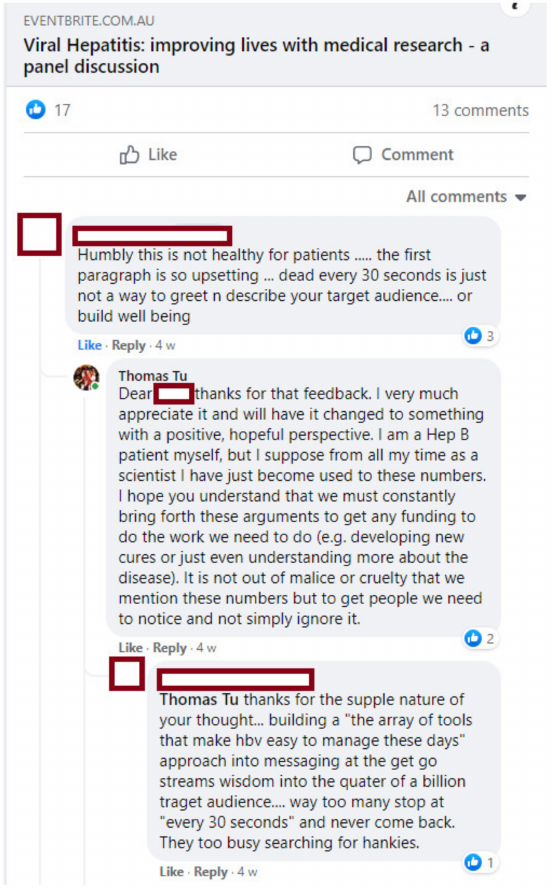
Figure 2. Facebook conversation about the event description and its unsuitability for the affected